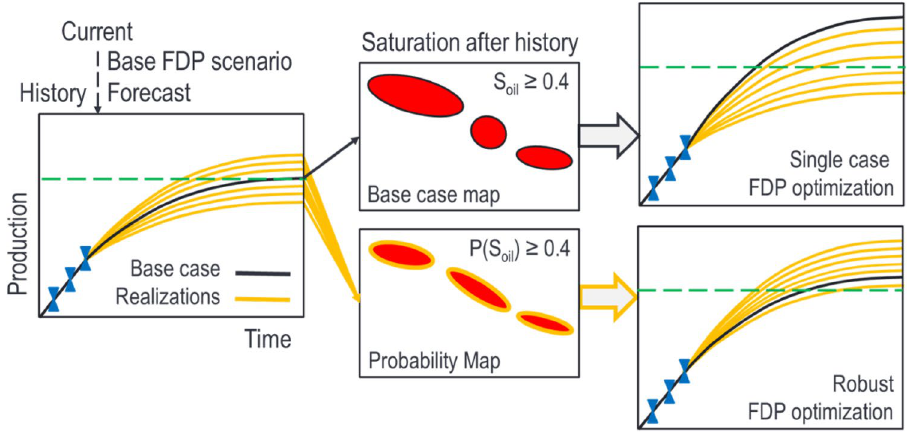
Fig. 1 Multiple‑realizations are history matched and meet historical production data (left). Multiple realizations (orange lines) are com‑ pared to a base case model (black line) for a field development sce‑ nario. At the current point of production, the area with remaining oil saturation higher than 40% is visualized for the base case scenario (upper middle). For the same time point of production a probability